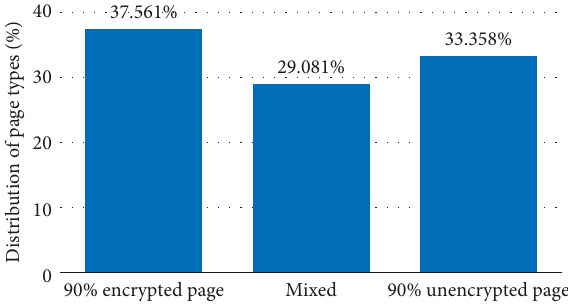
Figure 5: Page types by encryption.